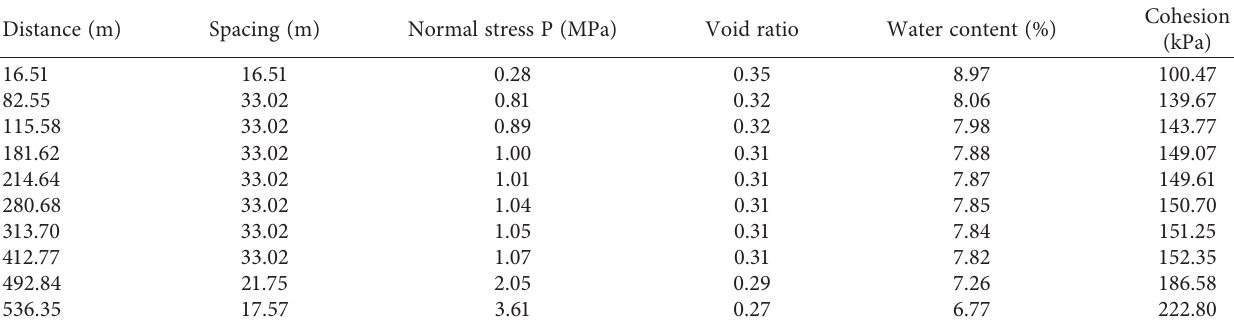
Table 5: C values of representative section of the sliding surface of Hejia landslide.